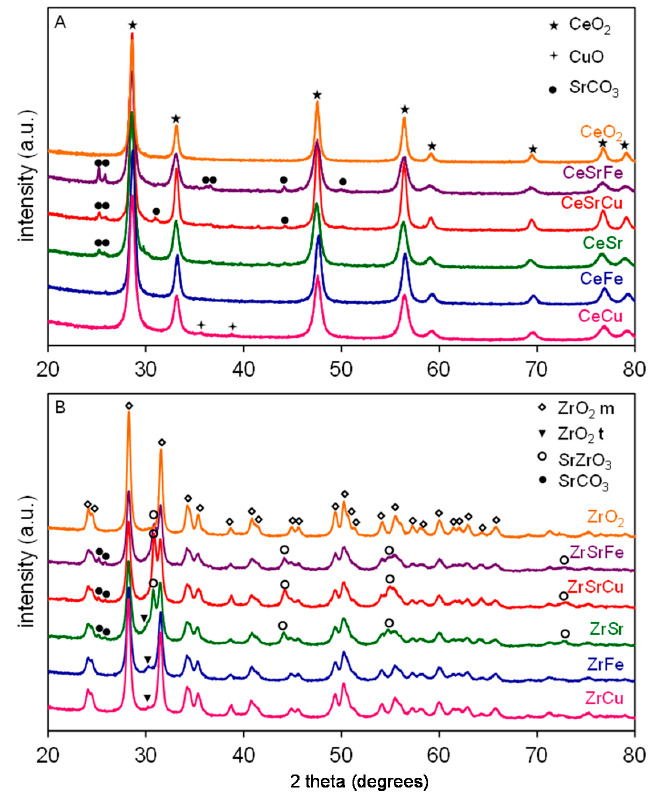
Figure 1. XRD diffraction profiles for ( A ) Ce ‐ and ( B ) Zr ‐ based catalysts.